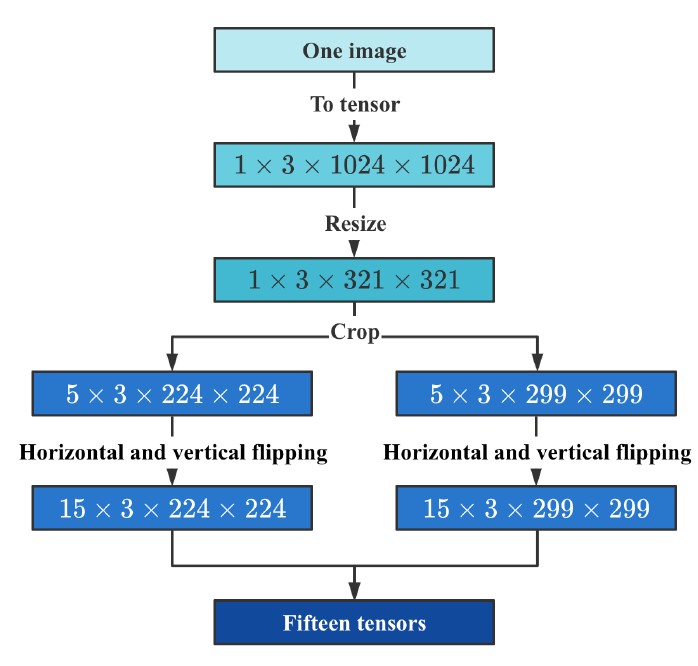
Figure 4. Single image augments to 15 images.